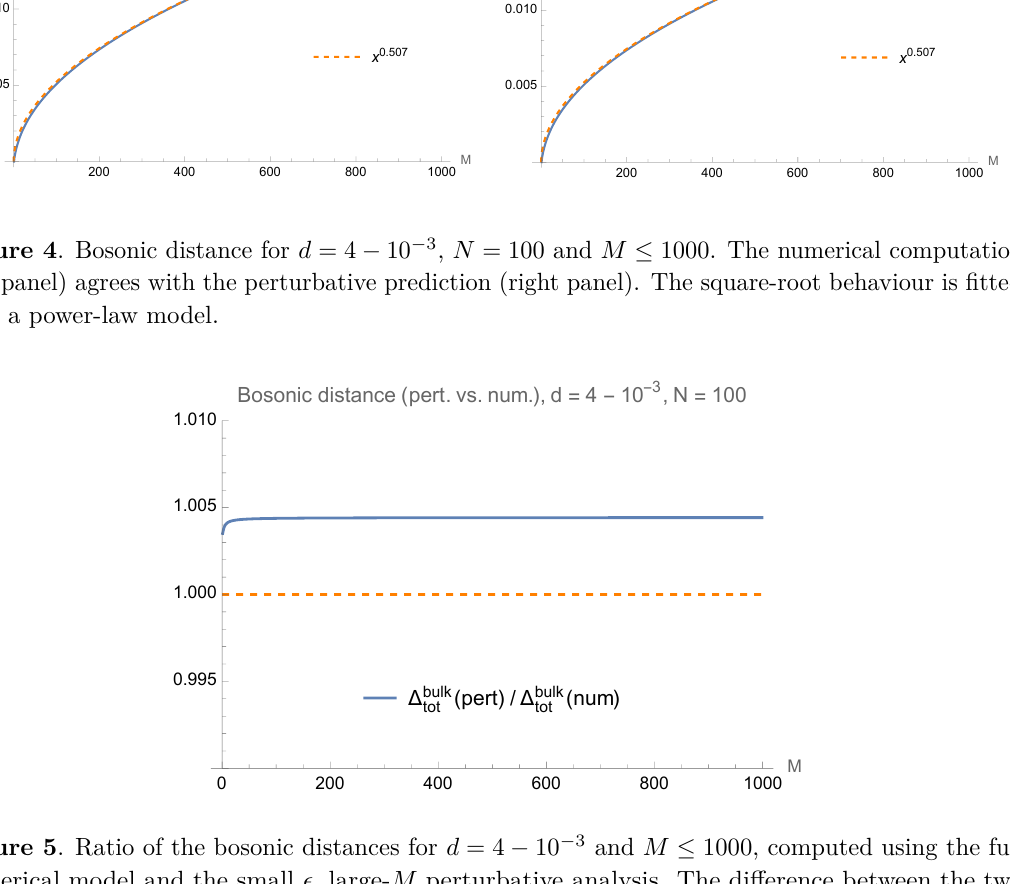
Figure 5 . Ratio of the bosonic distances for d = 4 − 10 − 3 and M ≤ 1000 , computed using the full numerical model and the small (cid:15) , large- M perturbative analysis. The difference between the two approaches gives an error less than 5 × 10 − 3